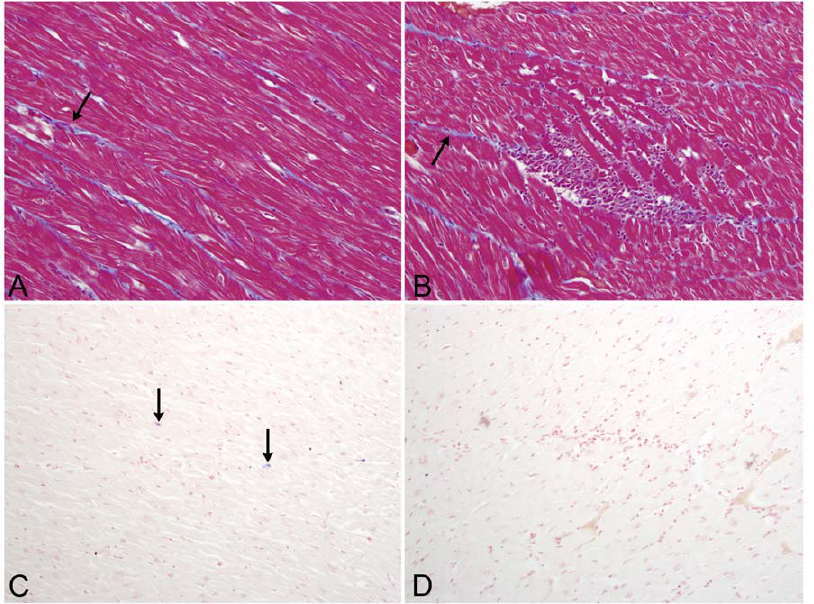
Figure 2. Masson’s trichrome staining and Insitu hybridization. Masson’s trichrome stain was performed to localize collagen fibers (blue stain, indicated by arrow) within myocardial sections of both control animals and animals that received CART. Significant fibrosis was not apparent in any animals from either group (200X). Small numbers of infected cells (blue chromogen) were localized by in situ hybridization for SIV RNA in myocardial sections from untreated, SIV-infected control macaques (C) and monkeys that received CART (D). NBT/BCIP chromogen (blue) with nuclear